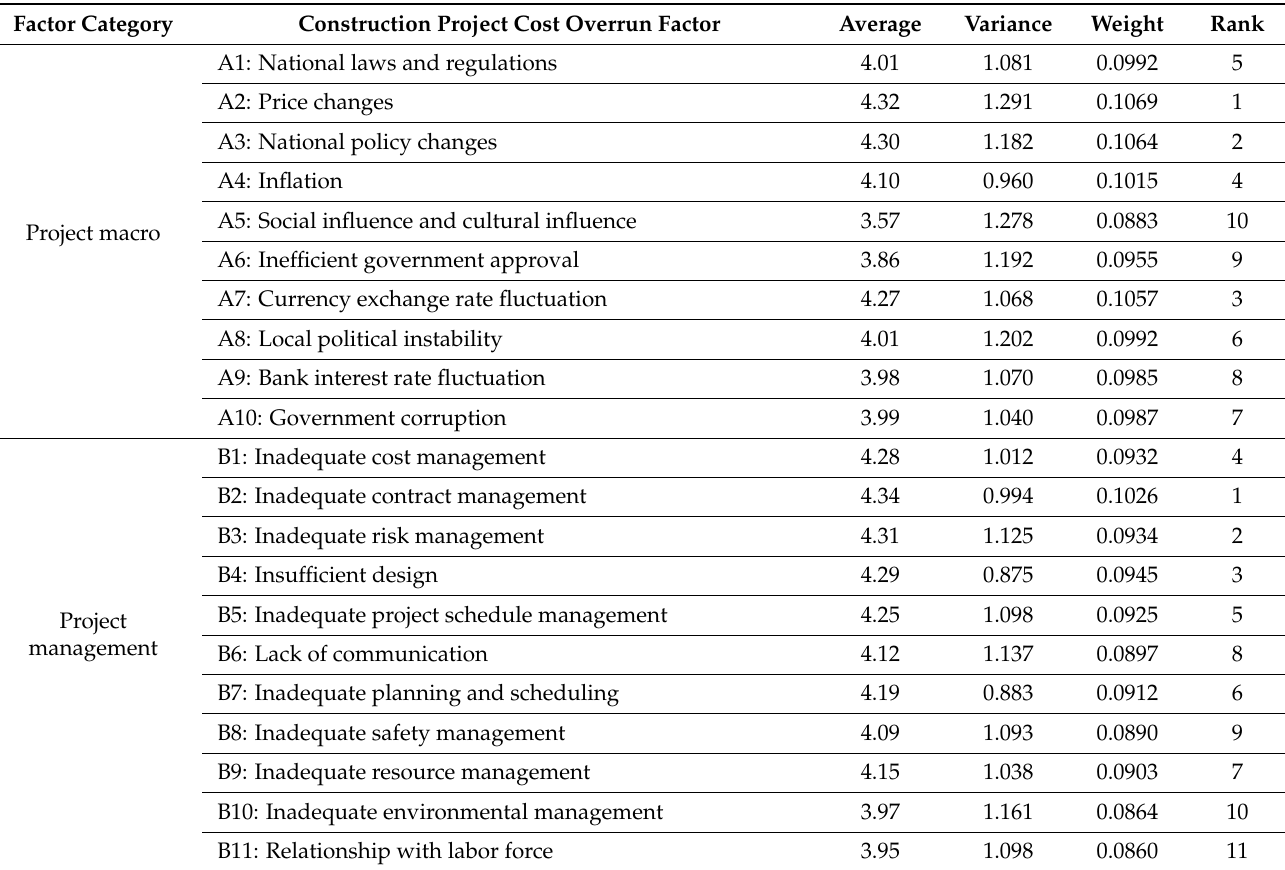
Table 4. Statistics of cost overrun